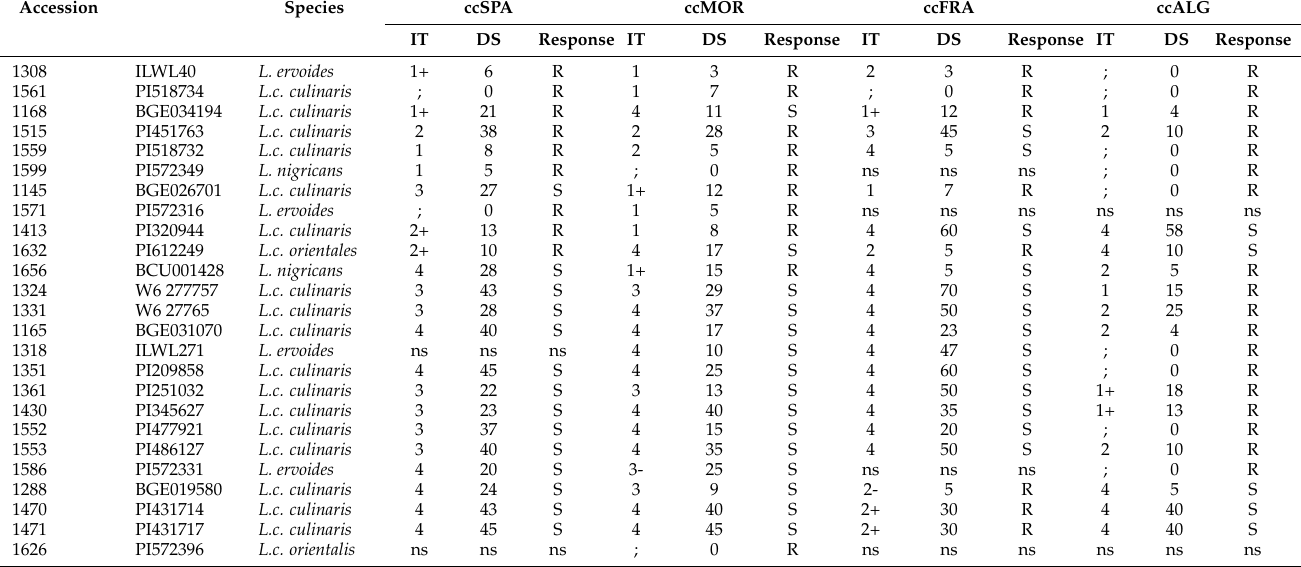
Table 5. Selection of accessions carrying hypersensitive response to any of the isolates of U. viciae-fabae ex L. culinaris studied. CcSPA = seedlings under controlled conditions inoculated with isolate SPA; cc- MOR = seedlings under controlled conditions inoculated with isolate MOR; ccFRA = seedlings under controlled conditions inoculated with isolate FRA; ccALG = seedlings under controlled conditions inoculated with isolate ALG; ns: not studied; IT = Infection Type according to Stakman et al. (1962) [29], where IT 0 = no symptoms, IT ; = necrotic flecks, IT 1 = min pustules barely sporulating, IT 2 = necrotic halo surrounding small pustules, IT 3 = chlorotic halo and IT 4 = well-formed pustules with no associated chlorosis or necrosis. Response R (IT < 3), S (IT ≥ 3).